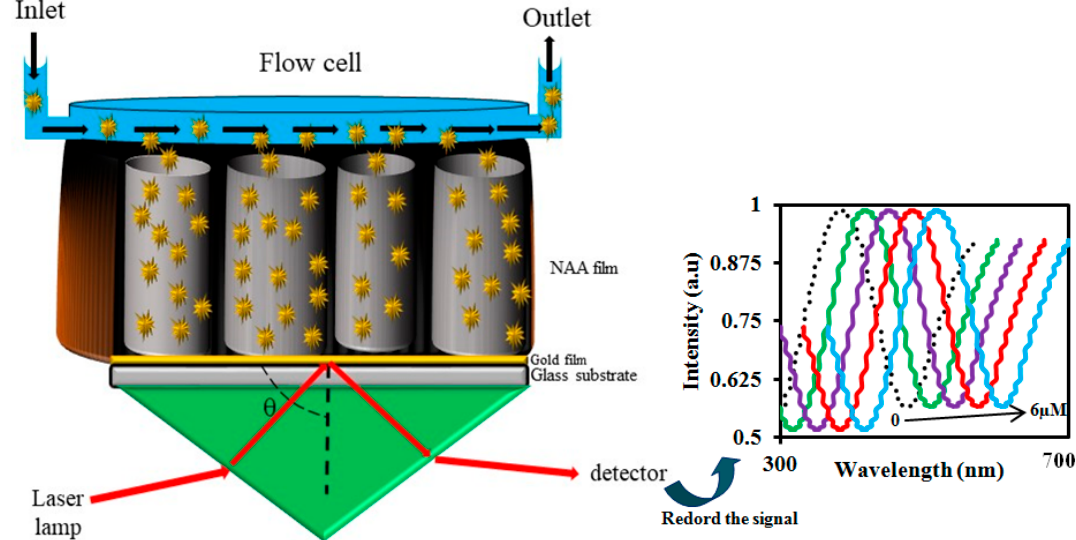
Figure 15. Schematic representation of the nanoporous optical waveguide (NPWG)-based sensing of bovine serum albumin (BSA) using nanoporous anodic alumina (NAA).